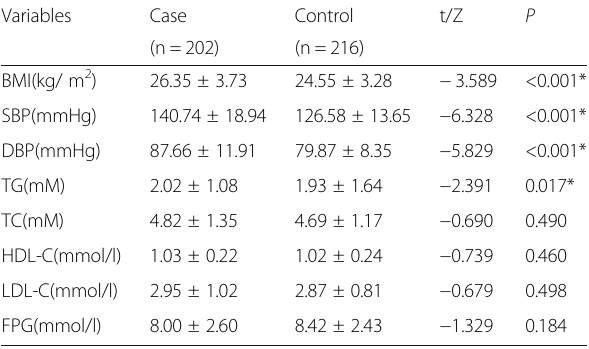
Table 3 Physical examination of the participants and blood biochemical analysis